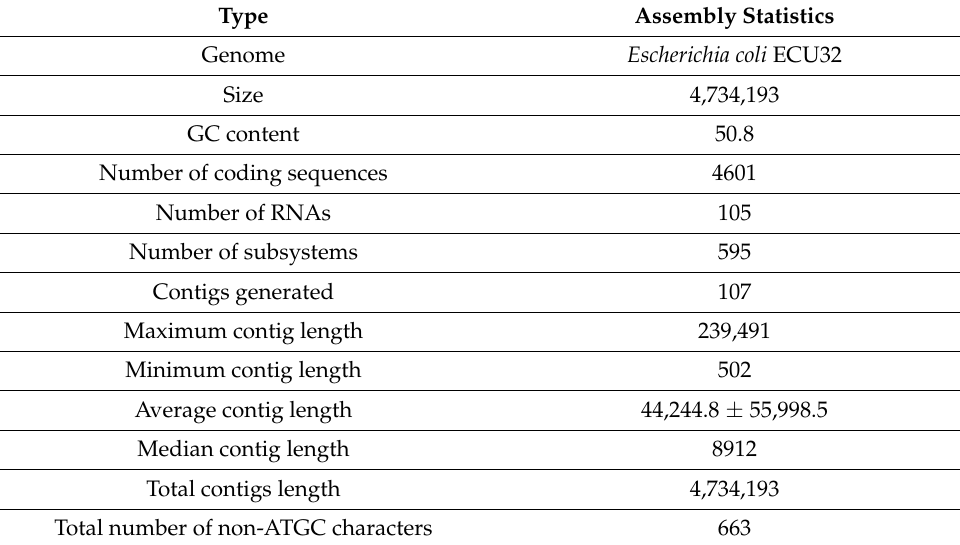
Table 1. Genomic features of E. coli